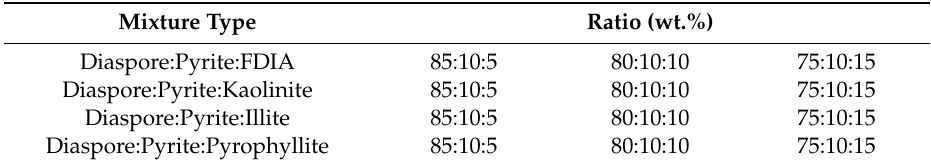
Table 1. Composition of artificially mixed ore. Mixture